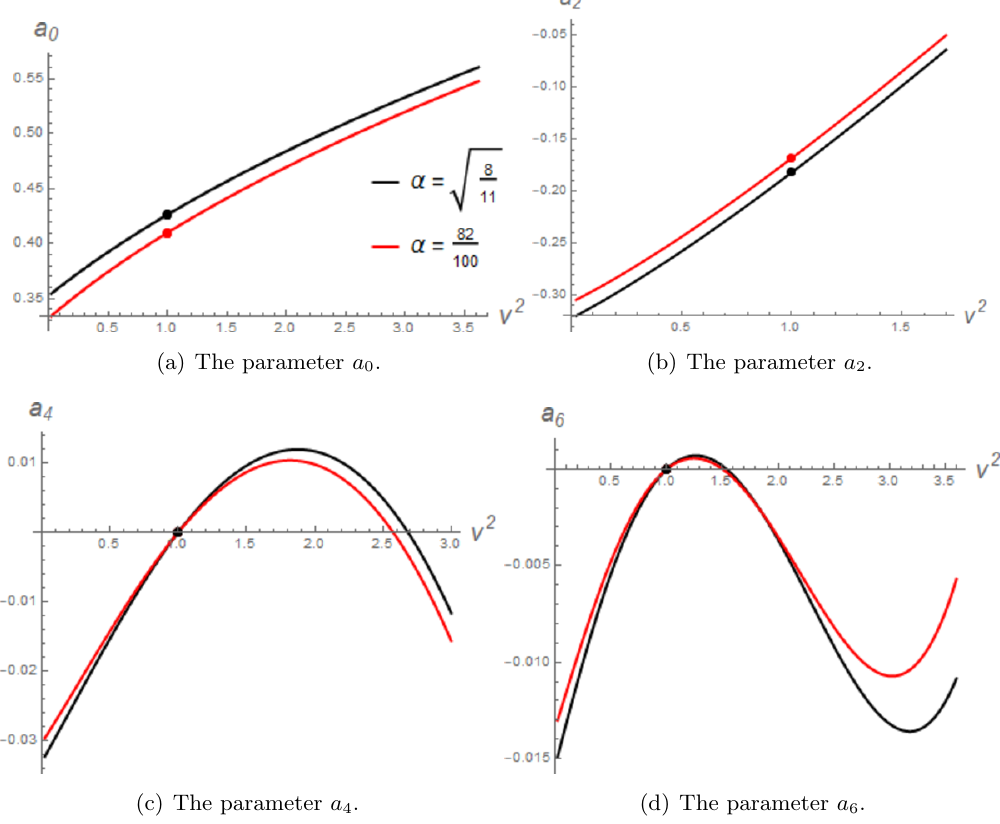
Figure 5 . The near-boundary parameters a 0 ; a 2 ; a 4 ; a 6 in terms of the squashing v 2 , for (cid:11) = 0 : 82 p (red) and (cid:11) = 8 = 11 (black).